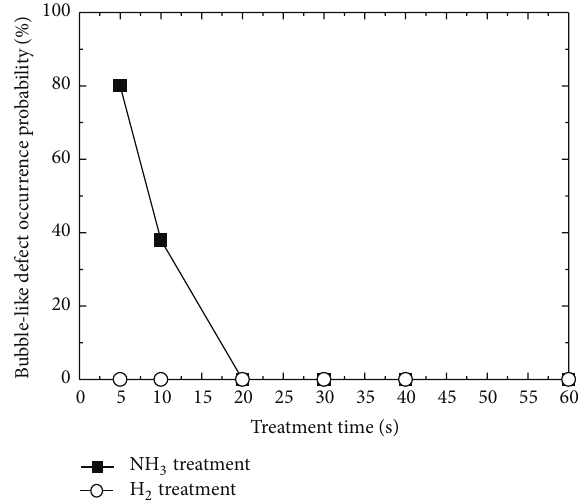
Figure 7: Probability of bubble-like defects formation under NH 3 and H 2 plasma treatments as a function of the treatment